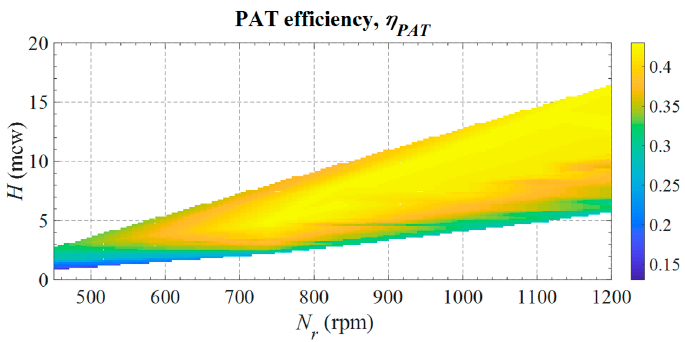
Figure 5. PAT efficiency experimental curve. Figure 5. PAT e ffi ciency experimental